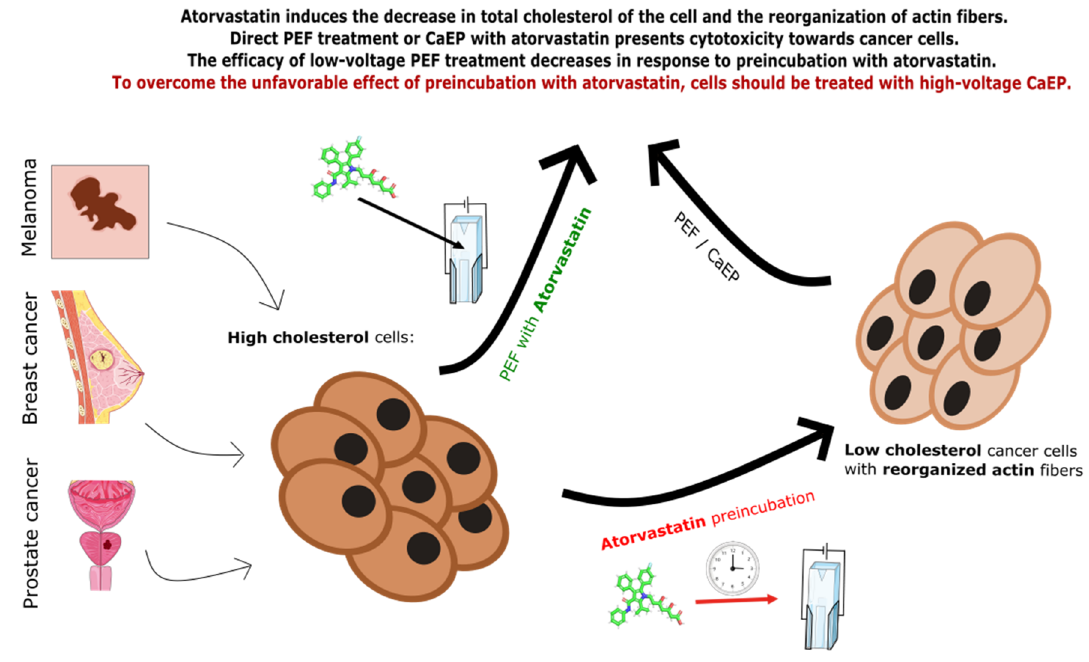
Figure 10. Study setup with the outcomes.